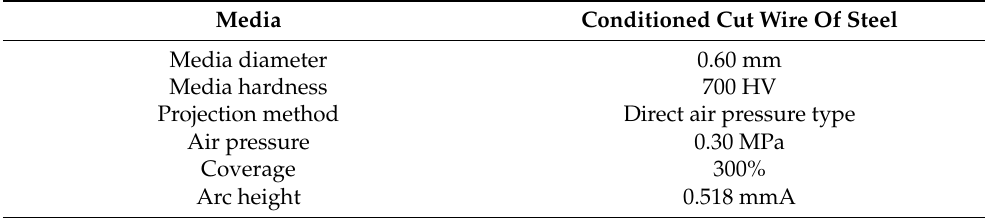
Table 2. Shot peening condition.